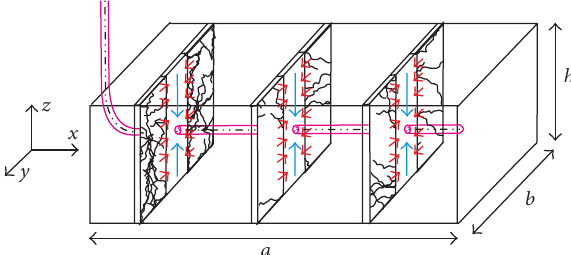
Figure1:Two-phaseflowinmultistagehydraulicfracturedhorizon- tal well in